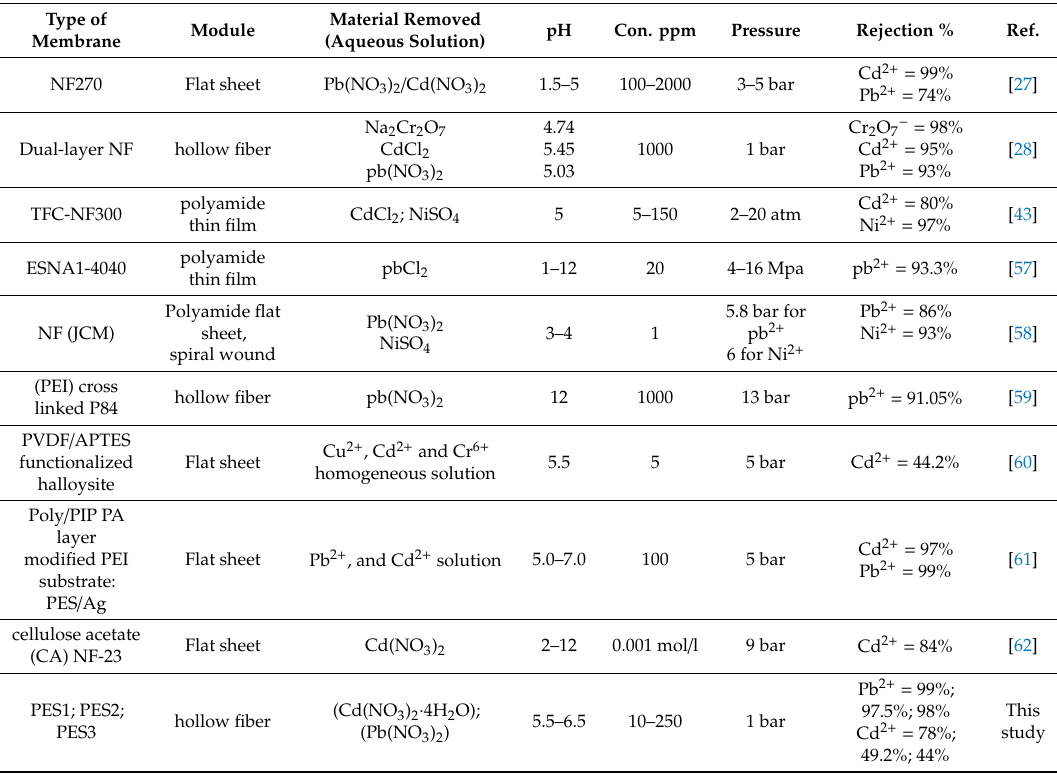
Table 7. Comparison between the performances of the current study and types of NF membranes presented in the